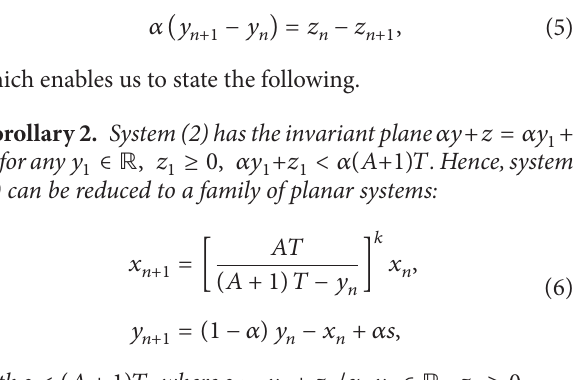
Table 1: Overview of conditions for existence and stability of the equilibrium points of